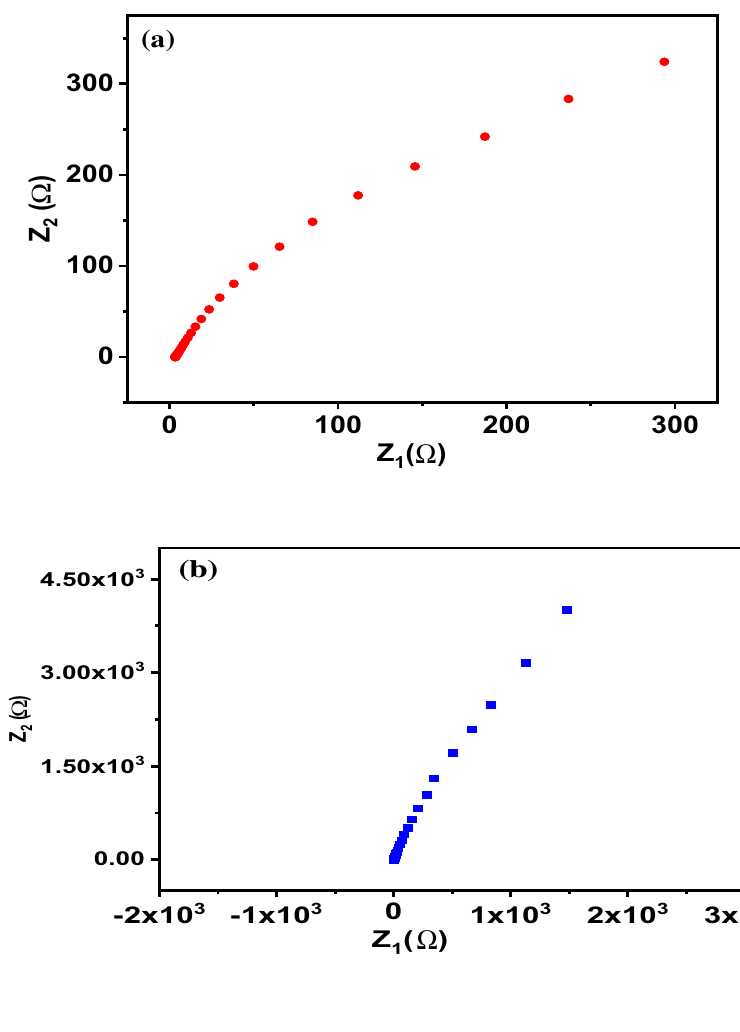
Fig. 10 a FRA impedance for CdS@SS electrode and b FRA impedance for CdS@Ni